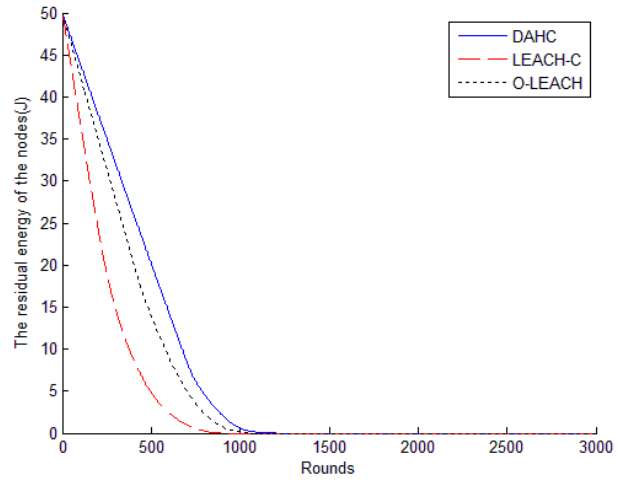
Figure 8. The residual energy of nodes versus rounds when the BS is outside.